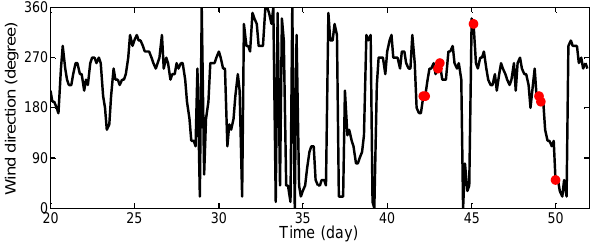
Figure 11. Wind direction for 20 June-21 July 2008 in Kalbadagrund (Finland); the circles show Fig. 11. Wind direction for 20 June–21 July 2008 in Kalbada- the times when freak waves of the Group II occurred. grund (Finland); the circles show the times when freak waves of the Group II occurred.